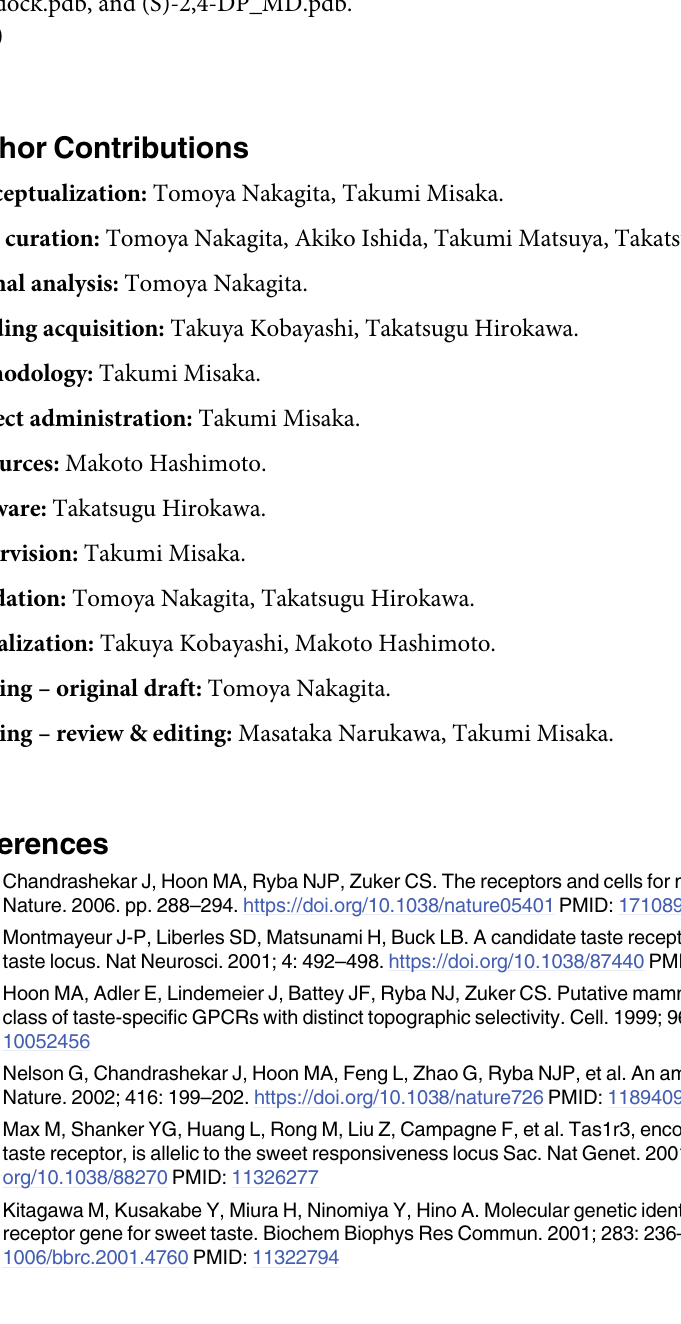
S8 Fig. Superimposed view of ( S )-2,4-DP model and other class C GPCR structures. Com- parison of the ( S )-2,4-DP minimized model and crystal structure of other class C GPCRs. MD- minimized models for ( S )-2,4-DP (green) and six other ligands (FITM from 4OR2, shown in light blue; mavoglurant from 4OO9, shown in orange; Compound14 from 5CGC, shown in violet; HTL14242 (Compound25) from 5CGD, shown in magenta; MMPEP from 6FFI, shown in dark gray, and fenobam from 6FFH, shown in light gray) are superimposed. (TIF) S1 Appendix. The models created in this study. Four models are available by